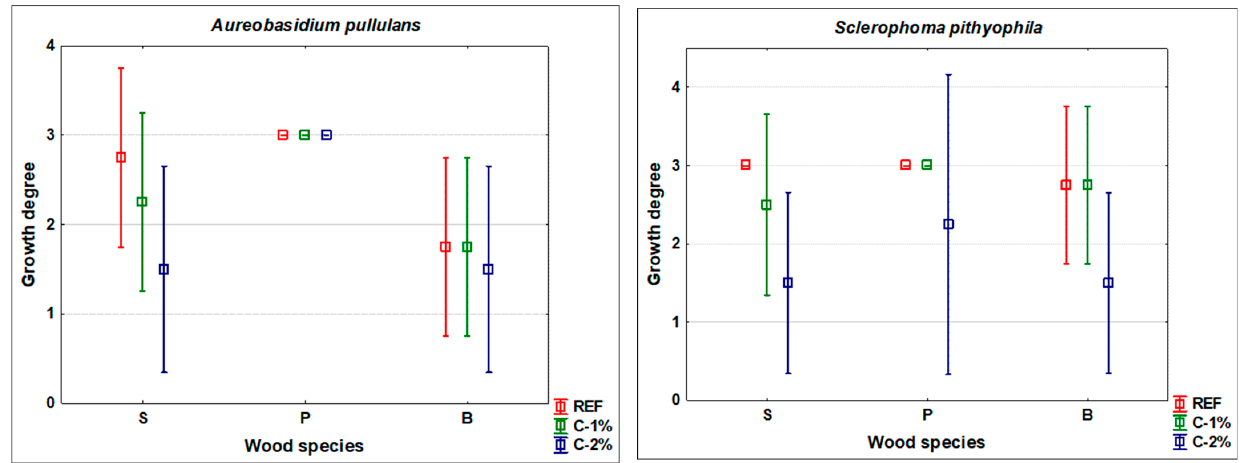
Figure 1. Blue-stain fungi growth.